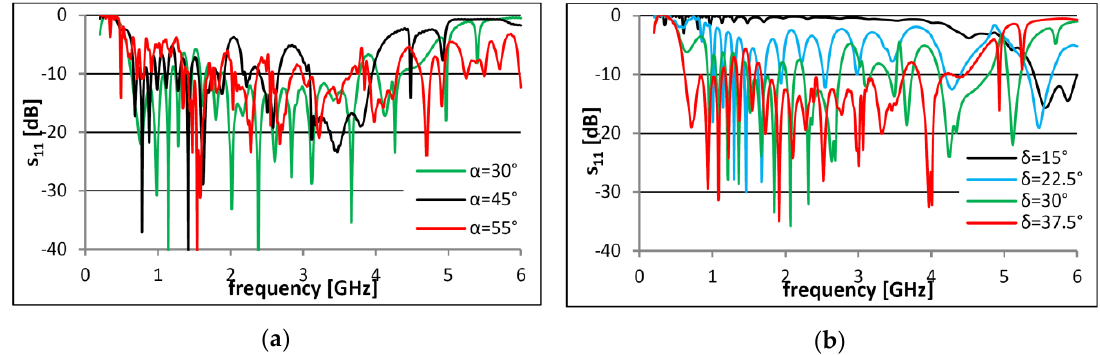
Figure 5. The simulated results (without ripples) for different values of the parameters: ( a ) α and ( b ) δ . Table 1. The resulting parameters of the manufactured antenna with coplanar waveguide (CPW) feeding.